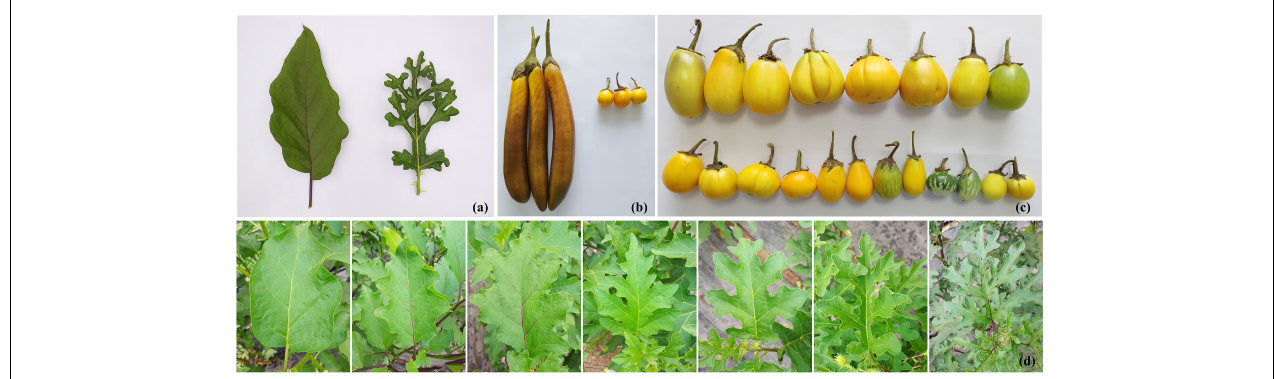
FIGURE 1 | Fruit and leaf morphology of the two eggplant parental lines and the F 2 population. (a) Leaves of Solanum linnaeanum “1809” (right) and S. melongena “1836” (left); (b) mature fruits of “1809” (right) and “1836” (left); (c) mature fruits of the representative F 2 individuals; (d) leaves of the representative F 2 individuals.